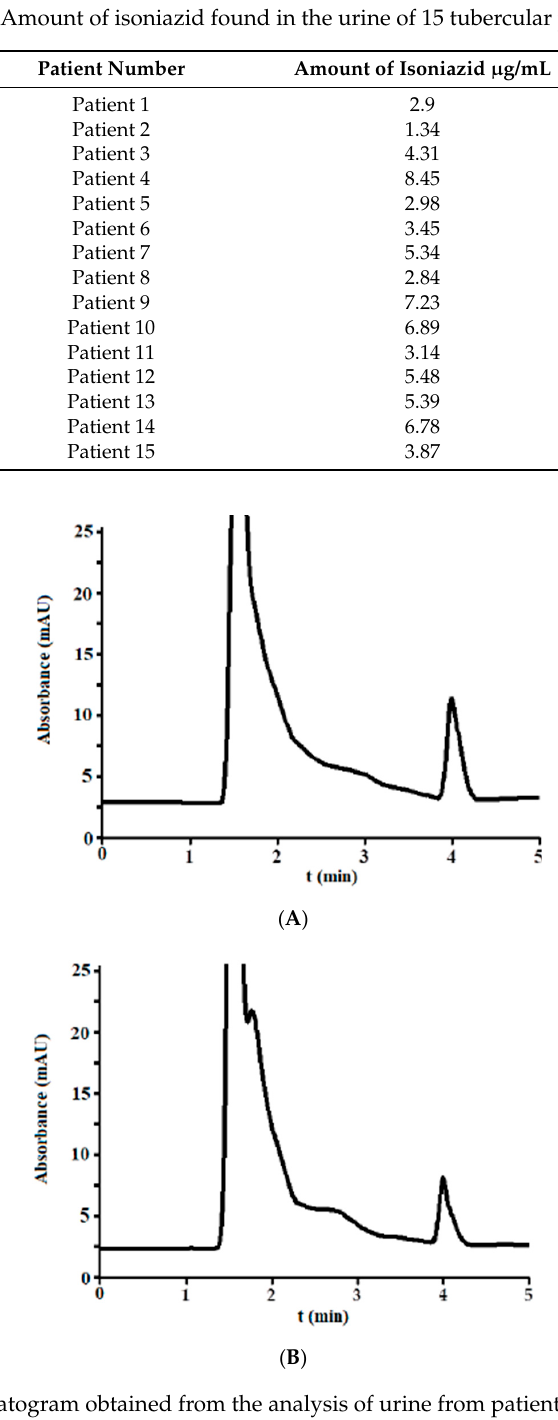
Figure 4. Chromatogram obtained from the analysis of urine from patients 1 ( A ) and 2 ( B ). Table 3. Amount of isoniazid found in the urine of 15 tubercular patients.